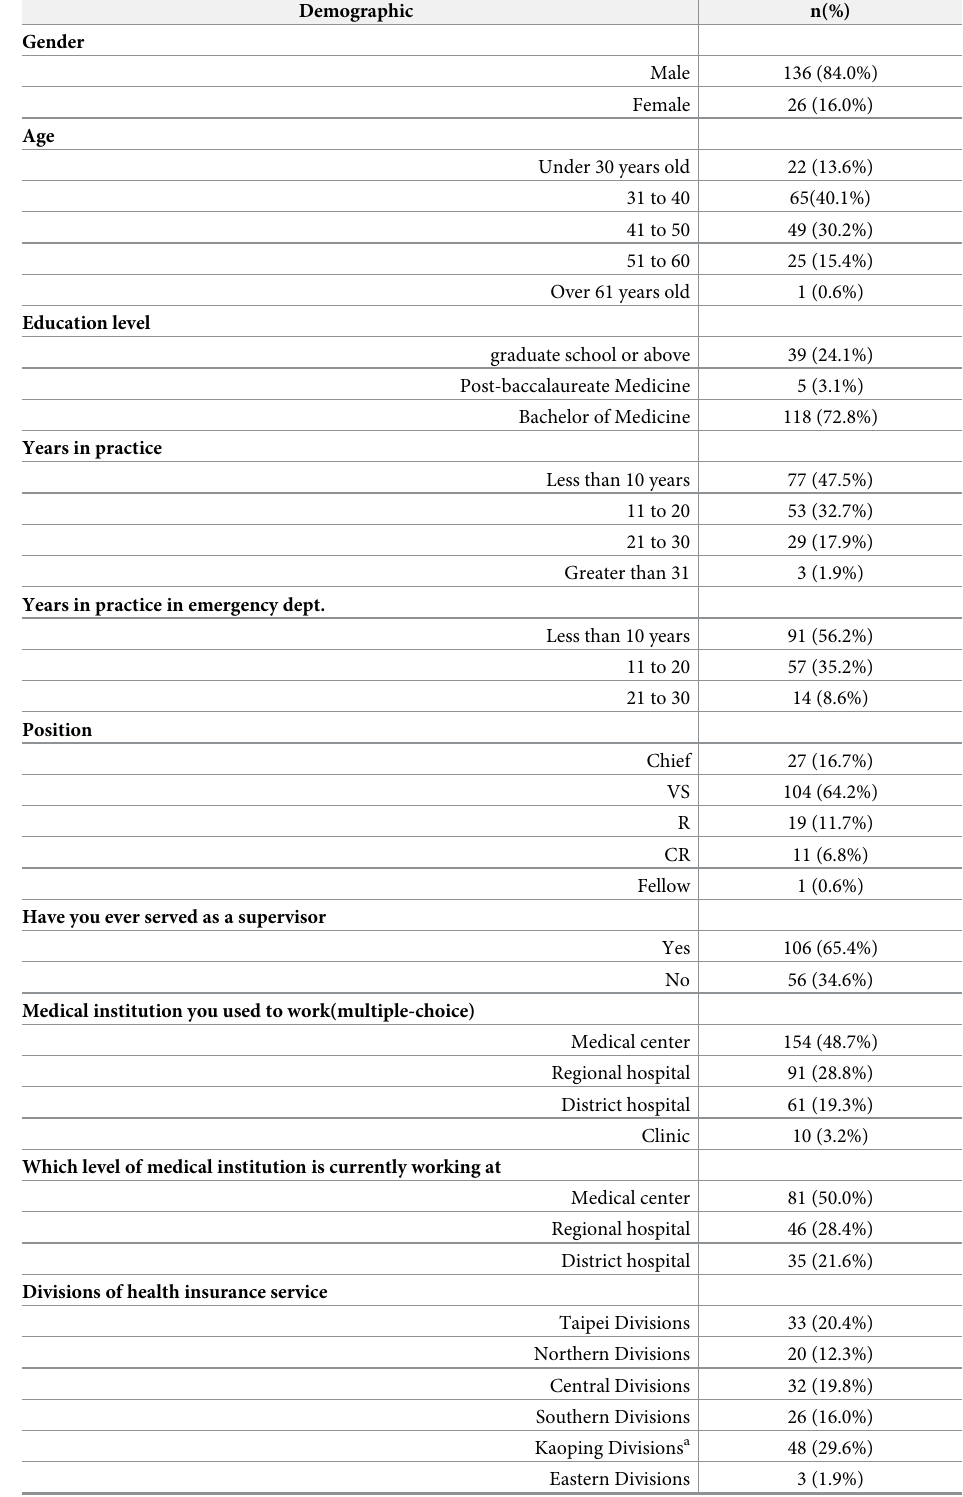
Table 1. Characteristics of participating